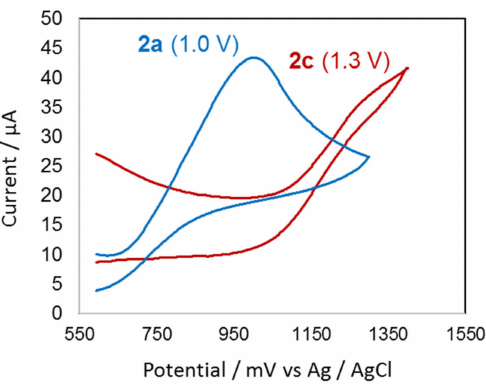
Figure 3. Redox behavior of NiBr(IPr)(PPh 3 ) ( 2a ) (blue line) and 2c (red line) in THF with Bu 4 NPF 6 (working electrode: Pt; counter electrode: Pt; scan rate: 100 mV · s − 1